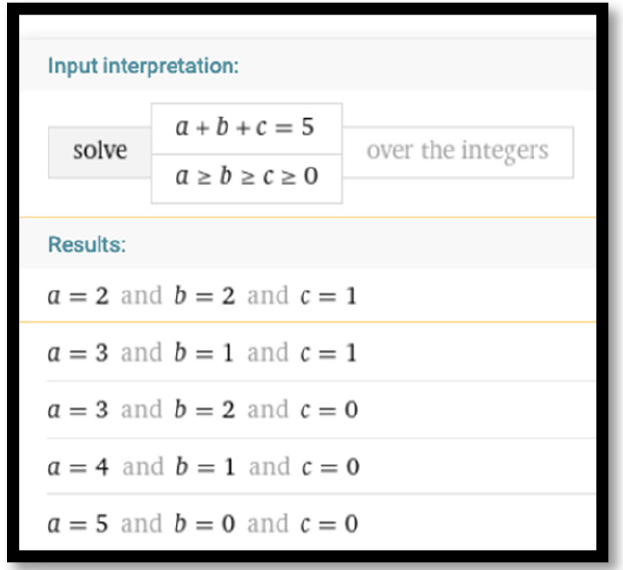
Figure 6. Using a Wolfram Alpha solution for posing a